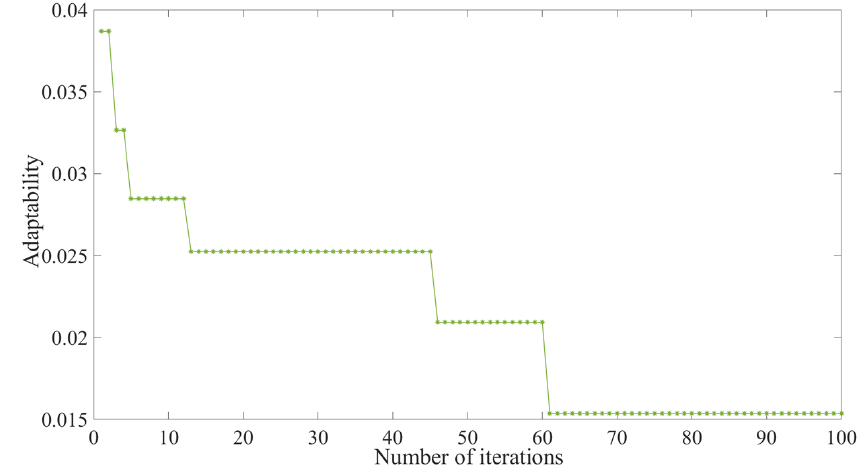
Figure 3. Adaptation curve of the PSO-BP model.